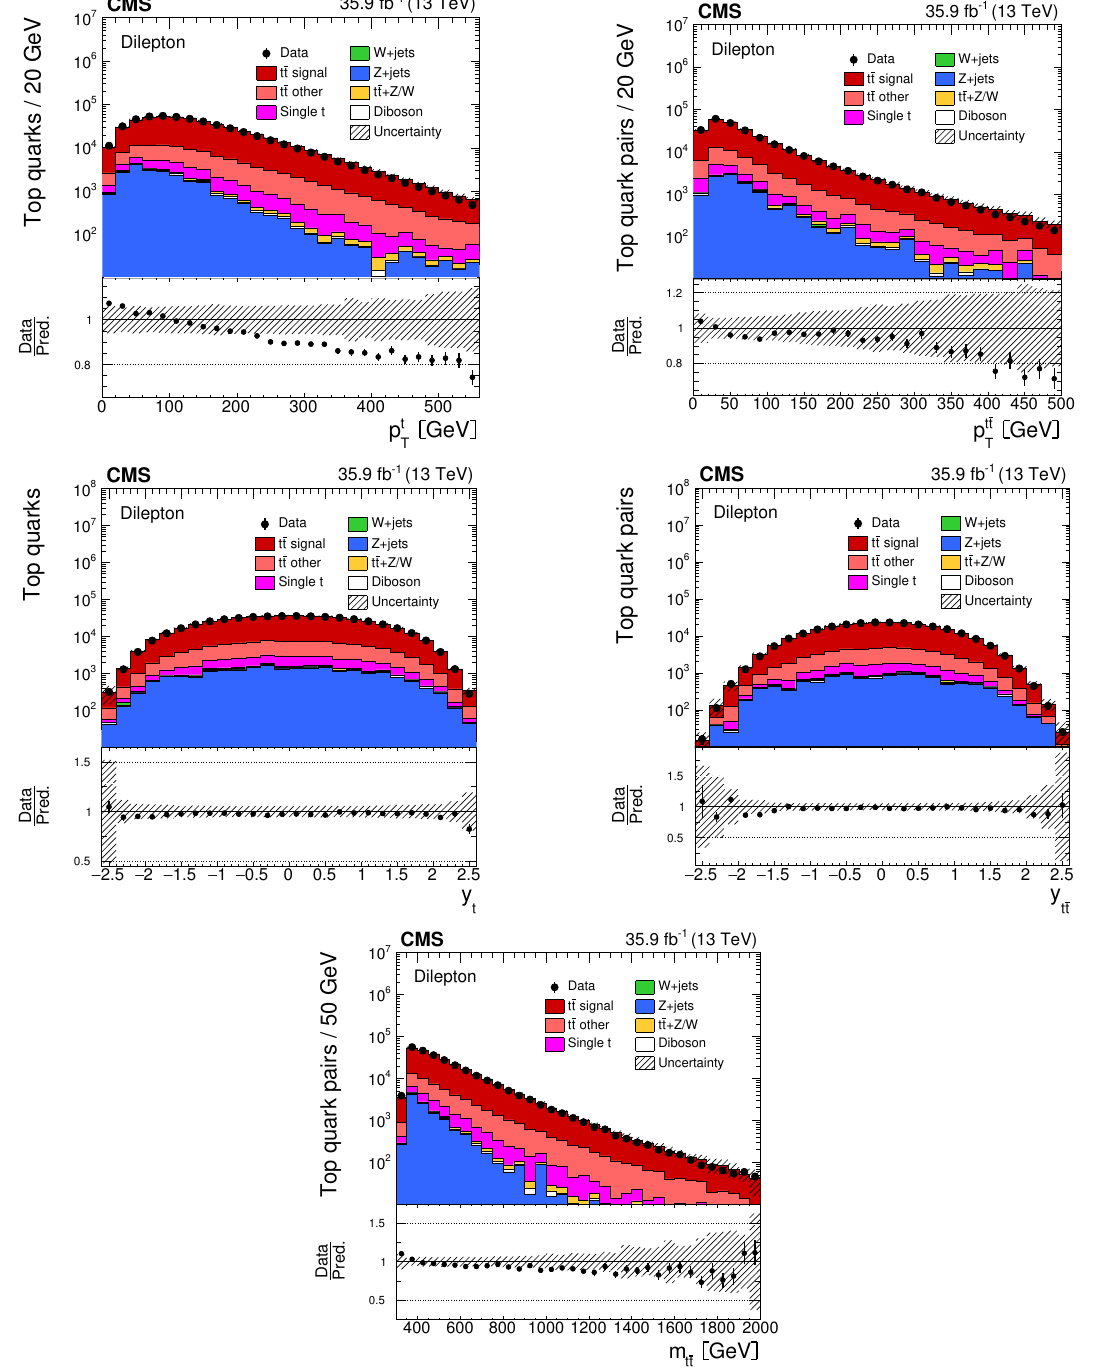
Figure 2 . Distributions of the p T (upper row) and rapidities (middle row), at detector level for the top quarks (left column), and tt system (right column), and m (lower plot) are shown for data tt (points) and simulation (histograms). The tt process is simulated with powheg + pythia . The vertical bars on the points represent the statistical uncertainties in the data. The hatched regions correspond to the systematic uncertainties in the signal and backgrounds, as described in section 6. The lower panel of each plot shows the ratio of the data to the predictions from simulation.